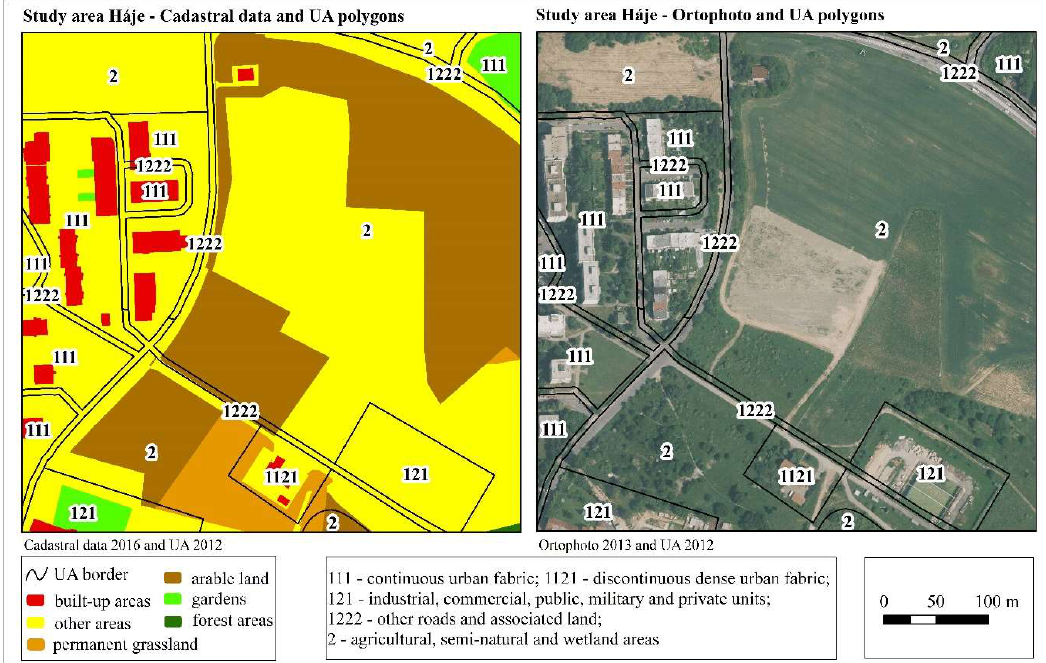
Figure 7. Map of the CU Háje. The colours symbolise the legend of the KN: red 13, yellow 14, light green 5, brown 2, black line polygon UA. Source: [32,34,36].